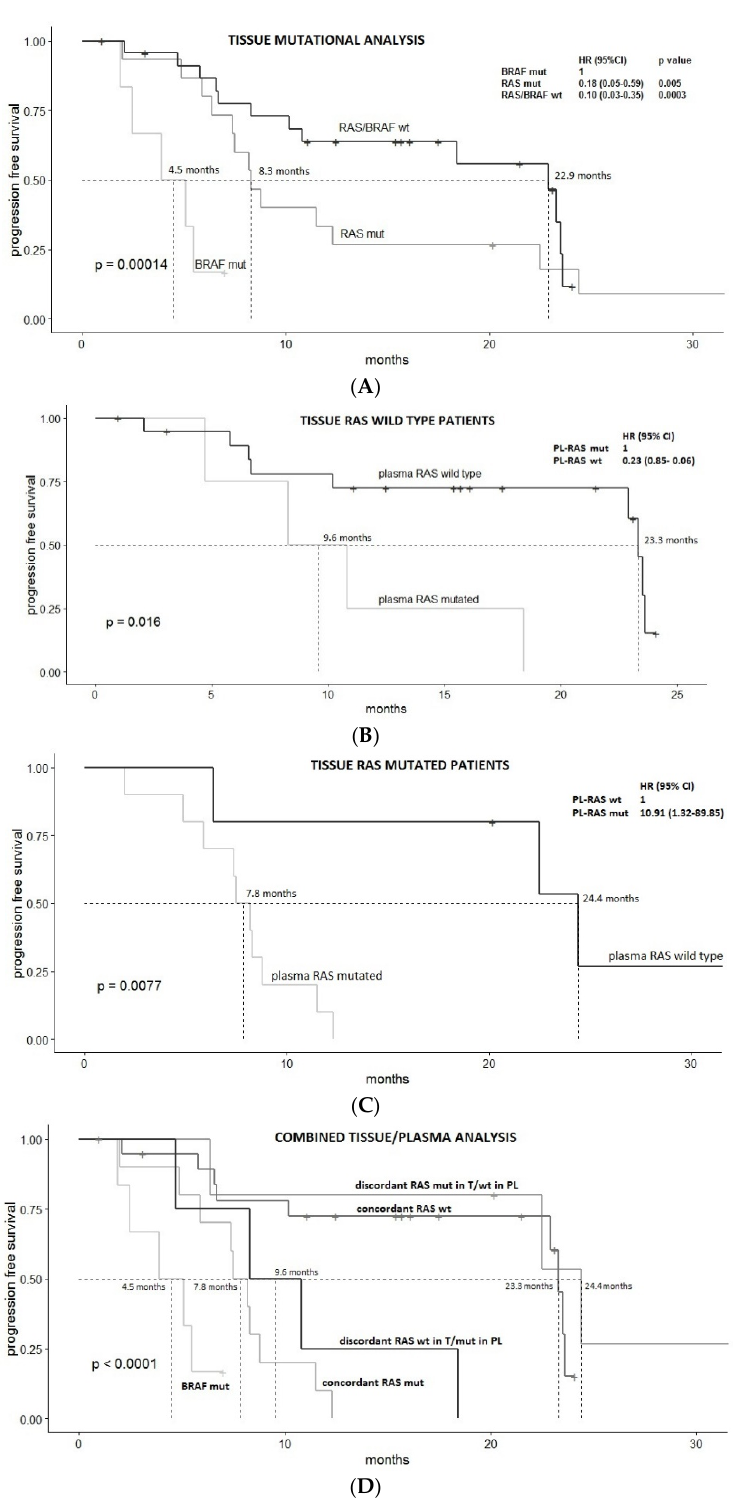
Figure 1. Progression free survival (PFS) analysis. ( A ): PFS according to tissue mutational analysis; ( B ): PFS in the tissue RAS wild type group according to the result of the liquid biopsy, ( C ): PFS in the tissue RAS mutated group according to the result of the liquid biopsy; ( D ): PFS in the five subgroups identified by the combined analysis of tissue and liquid biopsy. mPFS is indicated. p value in the bottom left angle refers to p value for trend for ( A , D ). BRAF V600E mutations were always consistently found both in plasma and in tissue (BRAF mut